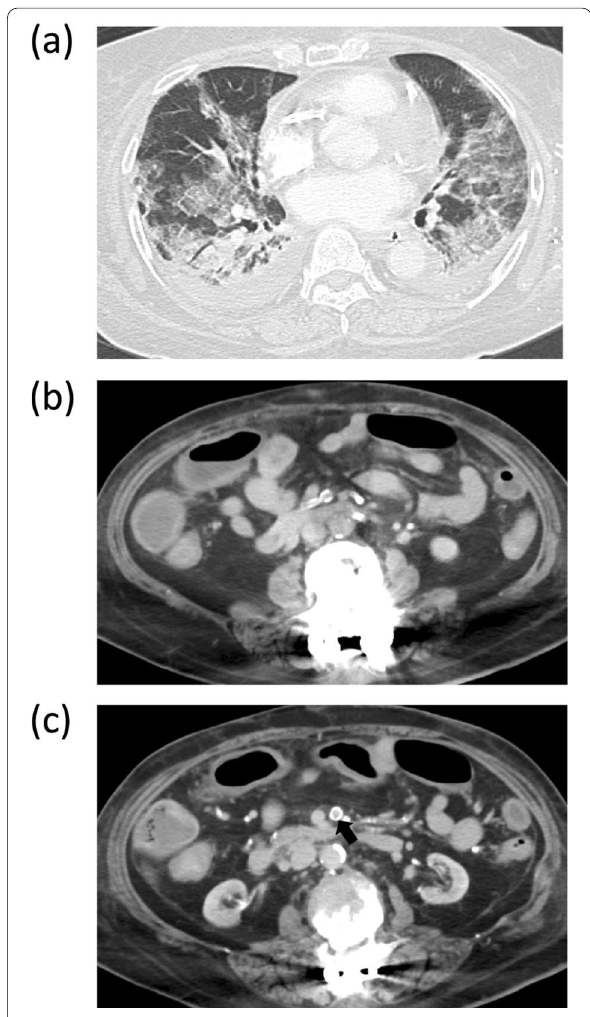
ground-glass opacity with lower-lung predominance ( a ). There were no obvious abnormal findings in the abdominal region or thromboembolism. The intestine, including the transverse colon was edematous ( b ). The superior mesenteric artery showed strong sclerotic changes ( c ,